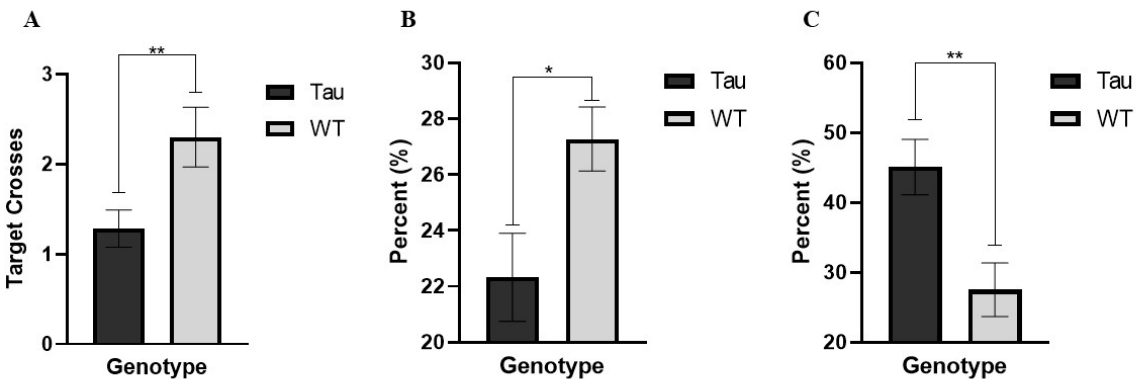
Figure 12. Additional MWM Probe Trial measures. ( A ) WT mice crossed the target significantly more than tau mice. ( B ) WT mice spent significantly more time in the target quadrant on the probe day than tau mice. ( C ) Tau mice spent significantly more time in the border (greater thigmotaxicity) than WT mice. Error bars represent mean ± SEM (* p < 0.05, ** p <